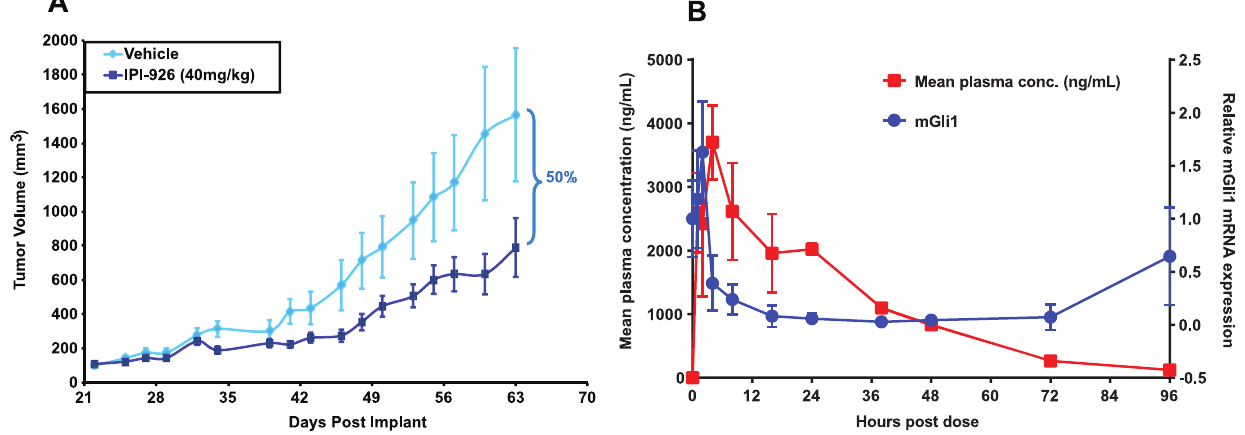
Figure 5. Hyper-responsiveness to paracrine Hh signaling was not observed in IPI-926 treated pancreatic xenografts. (A) In the MiaPaCa pancreatic xenograft model, 50% tumor growth inhibition was observed with daily oral administration of IPI-926 at 40 mg/kg (N=12 mice per group). (B) Plasma levels of IPI-926 correlate with the degree and duration of stromal mGli1 inhibition after a single dose of IPI-926 at 40 mg/kg. * indicates a p-value , 0.003. Modulation of tumor-derived hGli1 was not observed (data not